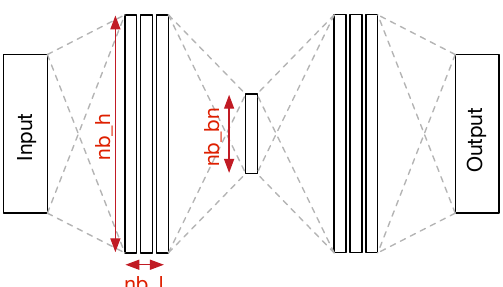
Figure 8. Varying parameters for the grid search of an Encoder–Decoder neural networks. nb _ l is number of layers of the encoder and the decoder, nb _ h is the number of hidden units for the encoder and decoder layers, and nb _ bn is the size of the bottleneck. We also use set different values for the dropout ratio ( r _ do